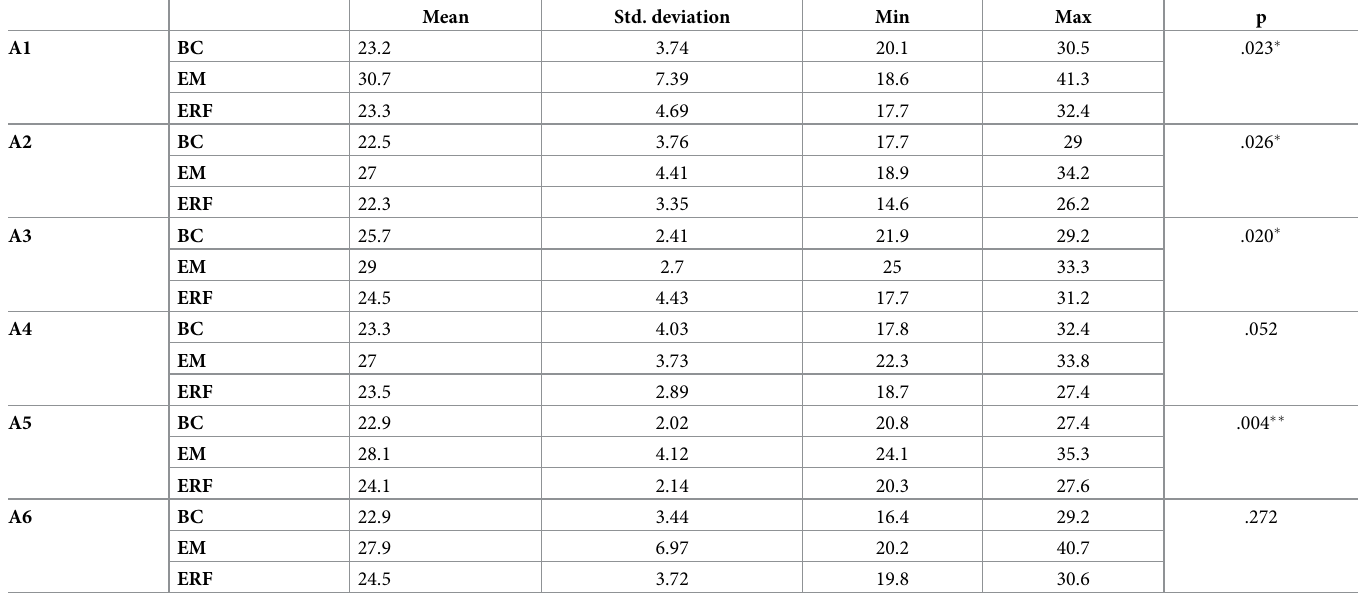
Table 5. Deviations ( μ m) occurred at abutments A1 to A6 for all groups ( � p < .05, �� p < .01).